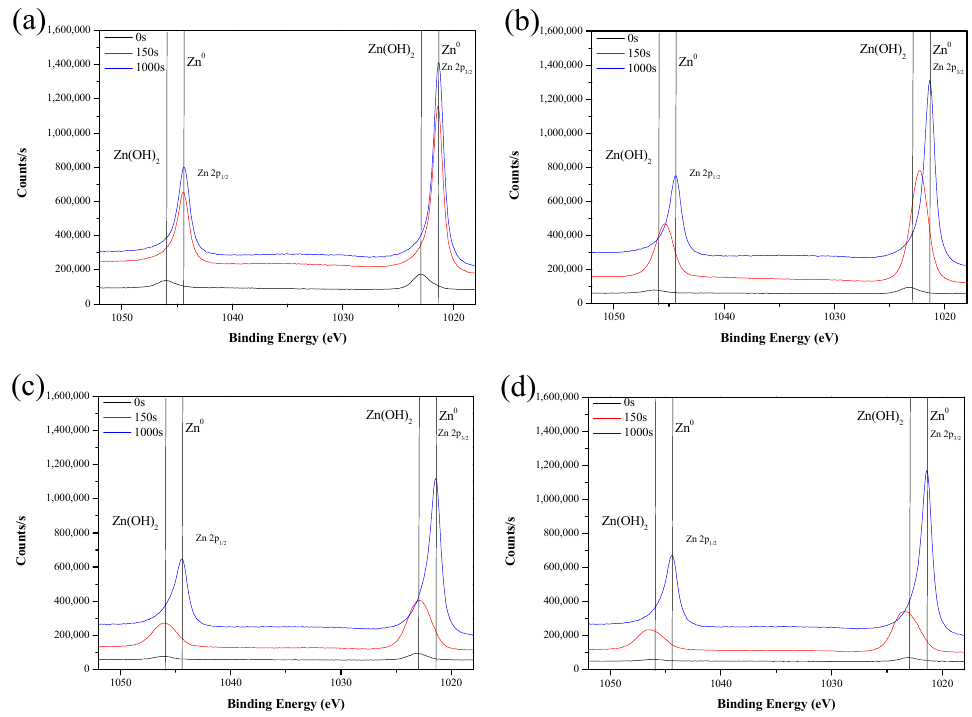
Figure 13. XPS spectra: Zn 2p binding energies determined from Zn 2p scans of ( a ) Zn–Ni alloy, ( b ) NaF 0% 60 s chromium conversion treatment, ( c ) NaF 50% 60 s chromium conversion treatment, and ( d ) NaF 100% 60 s chromium conversion treatment.